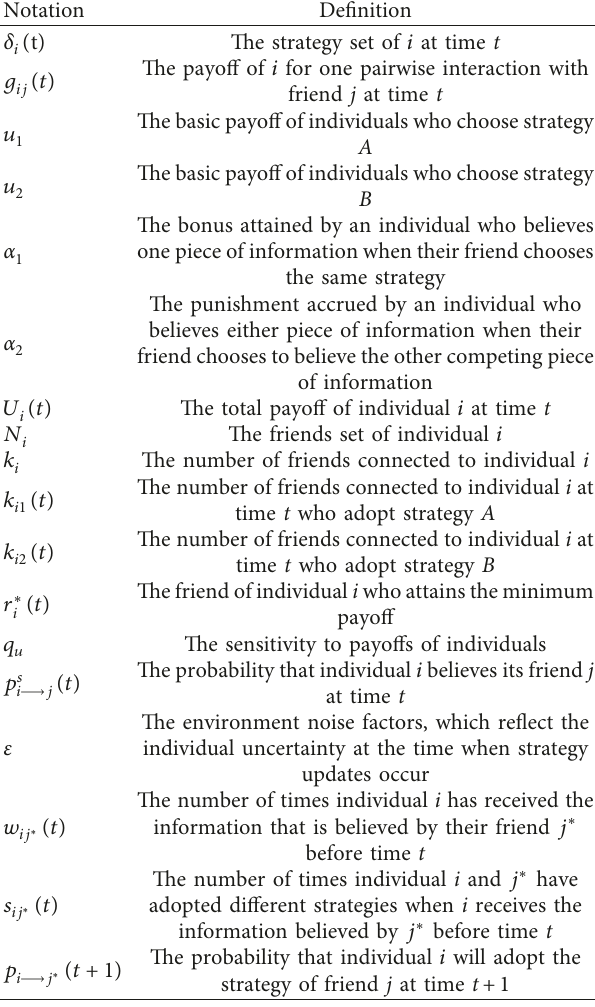
Table 1: Model notation and definitions.